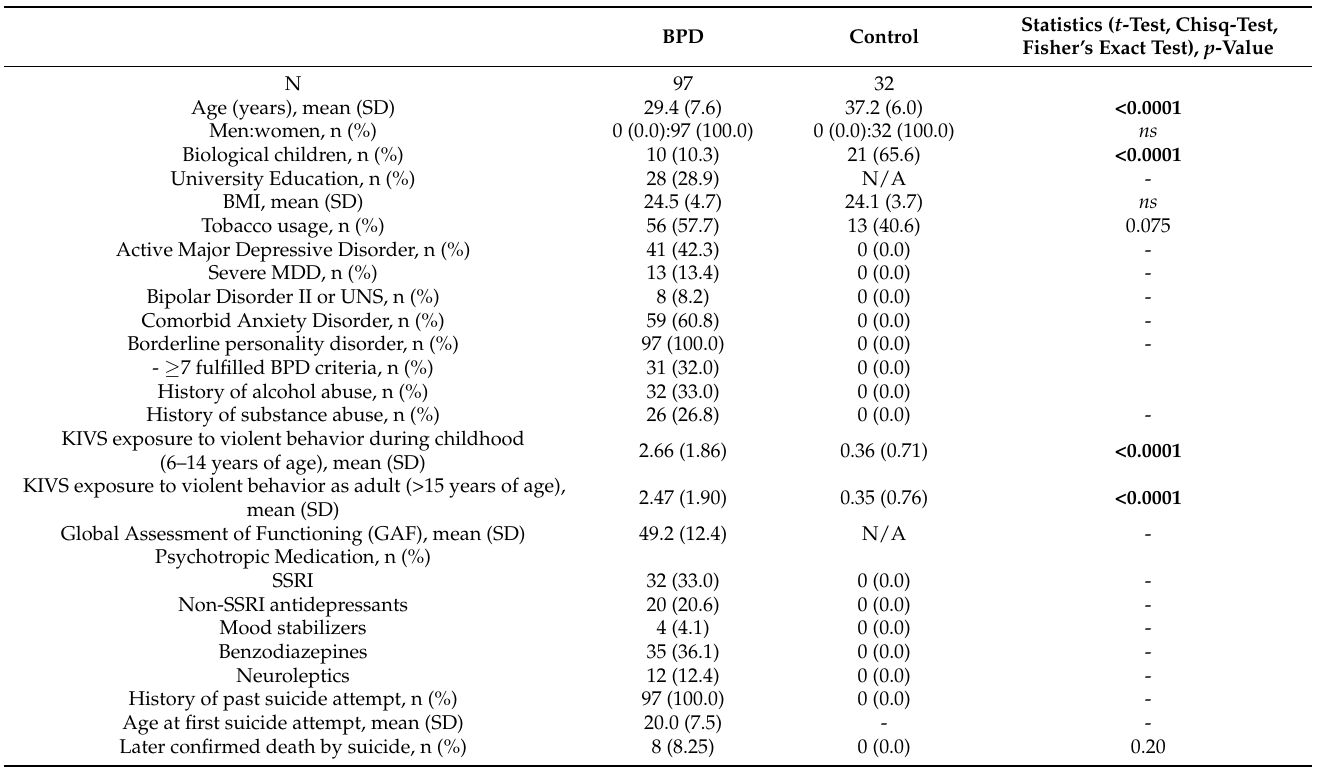
Table 1. Characteristics of subjects (EUPD